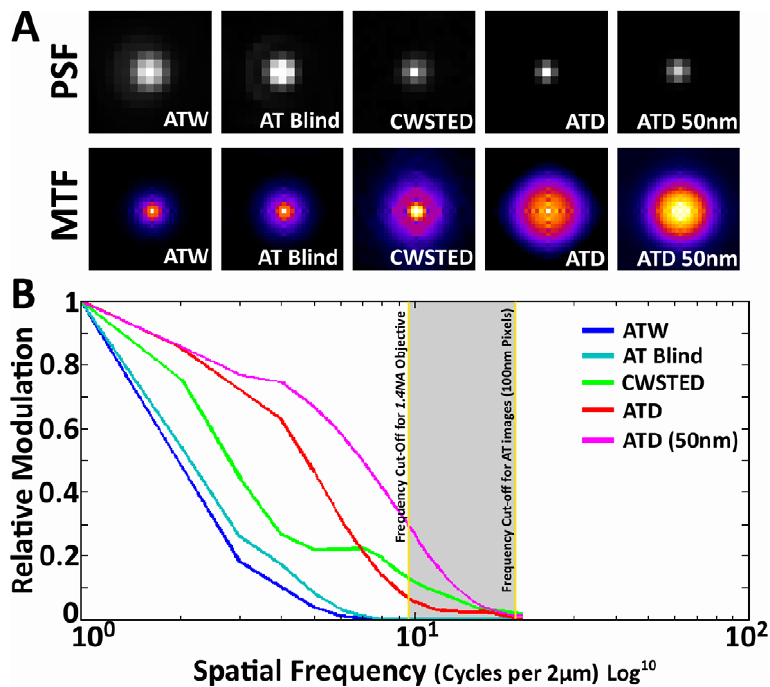
Figure 7. Comparison of measured MTFs. (A) Top row: the PSFs of ATW, AT with blind deconvolution, STED and ATD. Bottom row: the calculated MTF of the above modalities, which we accomplished by performing a FT on the PSF and graphing the modulus or the real component of the FT as a 2D intensity plot. (B) A plot of the rotationally averaged MTFs of ATW, AT with blind deconvolution, ATD and CWSTED. Yellow lines denote the theoretical cut-off frequency for a 1.4NA objective is calculated using 2NA/ l ( l =wavelength-488 nm, NA=numerical aperture-1.4). The grey region represents the frequency domain that is between the diffraction limit and the pixel limit of AT images. The frequencies in this region are not present in the actual recorded image, and ATD’s MTF extension into this region must be accounted for purely through analytical continuation by RL. In contrast, blind deconvolution does not apply analytical continuation and remains bandwidth limited by the cut-off frequency. CWSTED on the other hand clearly surpasses the diffraction limit and has 50 nm pixels. Further tests using ATD with 50 nm pixels (63 6 objective with 1.6 6 optivar) reveal that the MTF extension can be further pushed by allowing analytical continuation to continue further using a smaller pixel size.